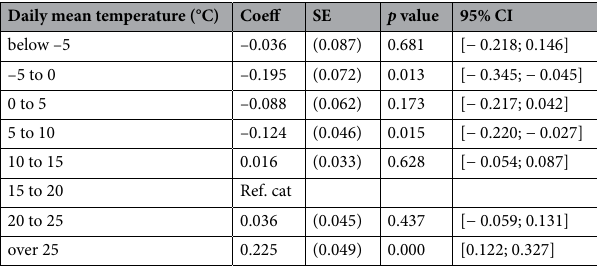
Table 1. Impact of early pregnancy temperature exposure on the clinically unobserved pregnancy loss rate. The coefficients show the impact of early pregnancy temperature exposure by temperature category. The coefficients represent the effect of one additional day with a given mean temperature on the clinically unobserved pregnancy loss rate relative to a day with a mean temperature of 15–20 °C. The early pregnancy period is defined as a six-week-long period starting after the week of conception. The estimations come from Eq. (9). The outcome variable is the clinically observed conception rate per week per 100,000 women aged 16–44 years, which is calculated using conceptions that end in clinically observed pregnancy outcomes. The impacts of temperature exposure on the clinically unobserved pregnancy loss rate are obtained by multiplying the estimated temperature coefficients by − 1. The model has county-by-year fixed effects, region-by-calendar- week fixed effects, and region-by-calendar-week-specific quadratic time trends. Precipitation, pre-conception weather, and the share of non-working days are controlled for. We weight by the counties’ average female population size (aged 16–44 years) between 1981 and 2015. Standard errors are clustered by county and time.